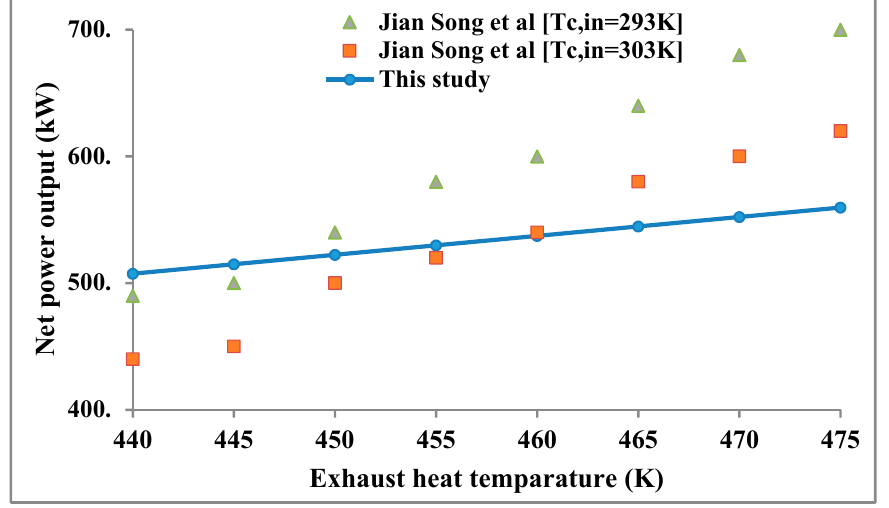
Figure 4. Net power output vs. exhaust heat temperature.